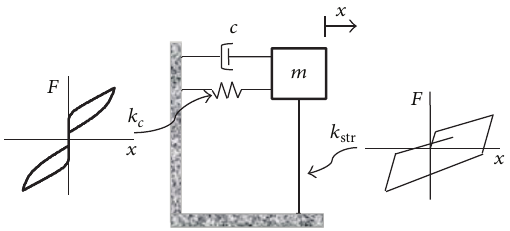
Figure 1: Equivalent single-degree-of-freedom